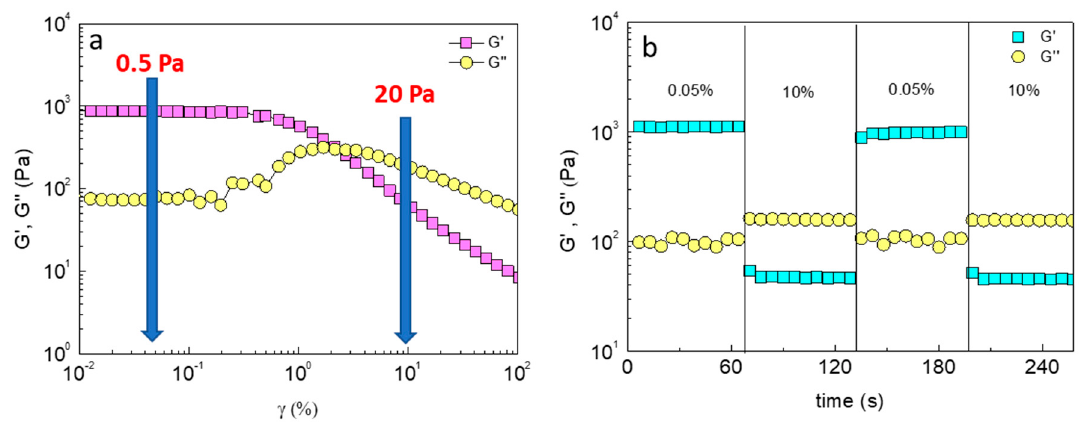
Figure 6. ( a ) G’ and G” as a function of strain at 1 Hz and ( b ) consecutive time sweep at fixed strain amplitudes as indicated by the arrows in ( a ), i.e., at 0.05% (LVR) and 10% (beyond LVR) of PAA-g-P(b-LL) aqueous solutions of C p = 0.74 wt%.